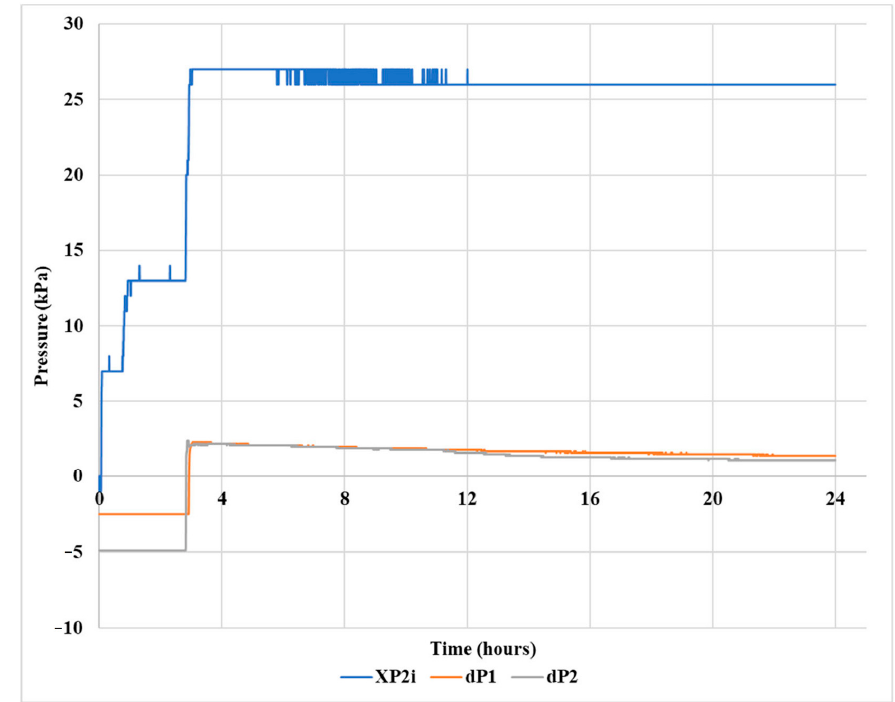
Figure 12. Recorded pressure during an experiment in a column deviated 40 ◦ from vertical using the bentonite gel pill. The bottom hole pressure is shown as the blue line. The differential pressures dP1 and dP2 are shown as the orange and gray lines, respectively. Energies 2020 , 13 , x FOR PEER REVIEW